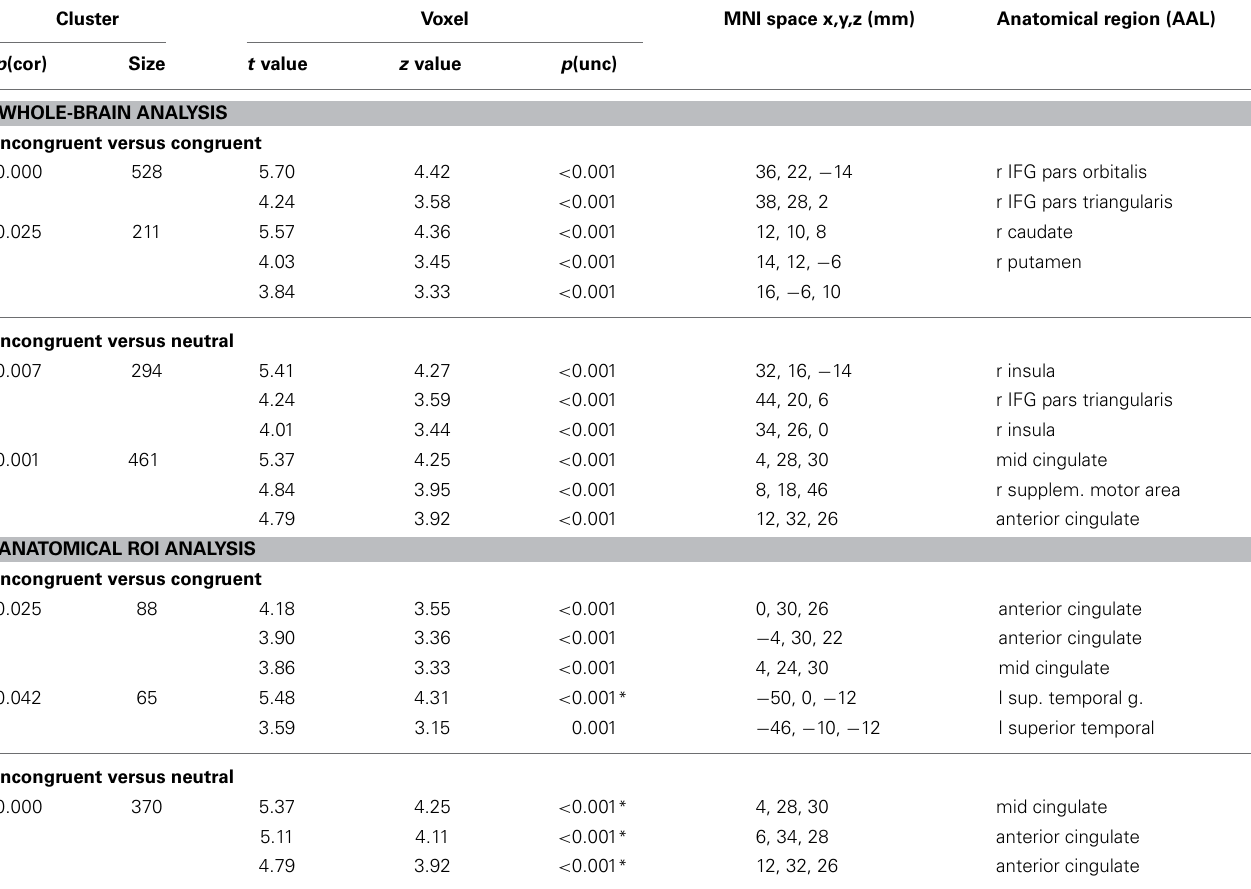
Table 6 | Statistically significant activations for the Stroop task in the whole-brain and ROI analyses (cingulate and left superior/middle temporal